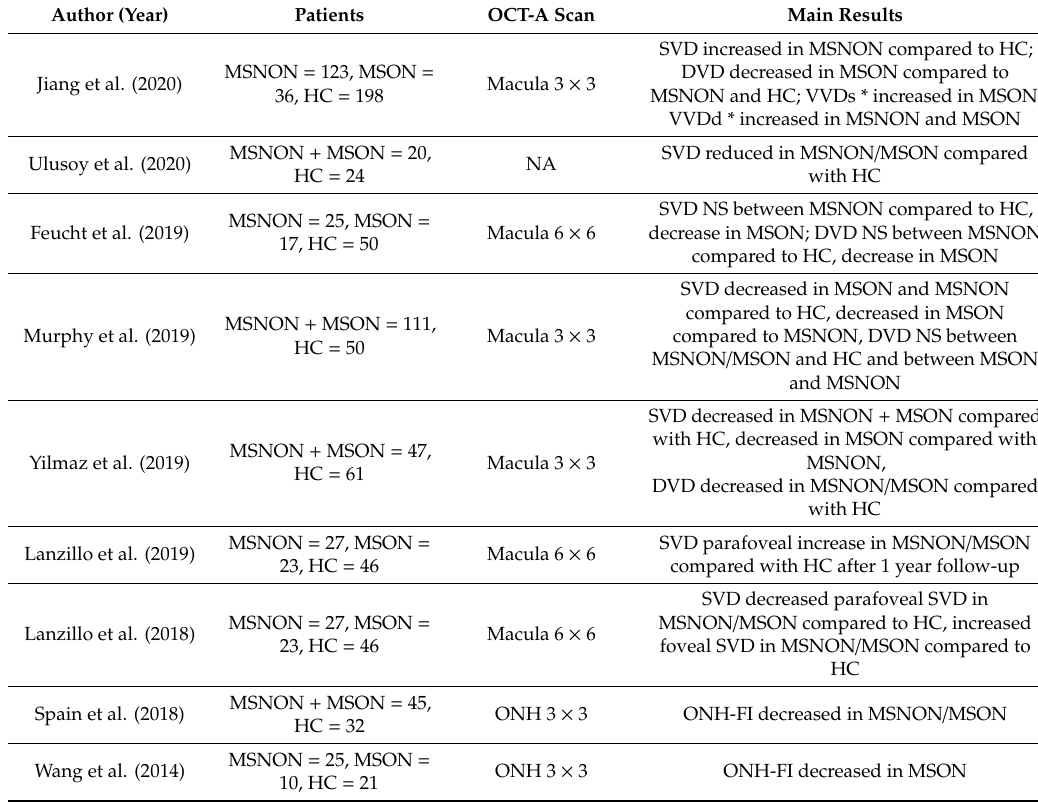
Table 2. Characteristics of studies evaluating ocular coherence tomography angiography in patients with multiple